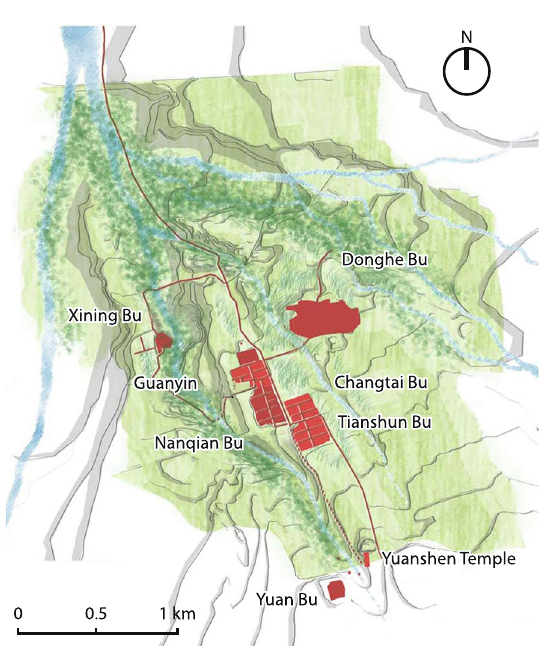
Fig. 7 Natural environment with the coexistence of water and earth (Source: Tongji University and Ecole de Chaillot